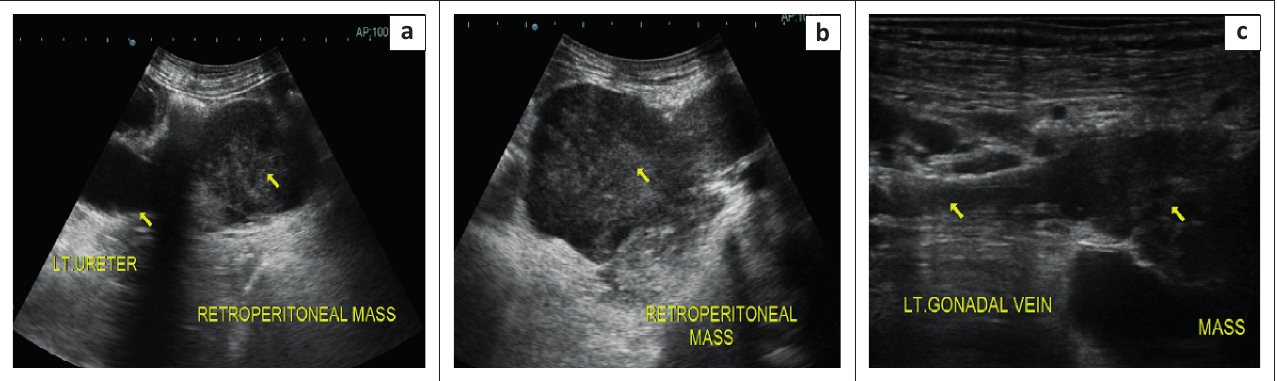
FIGURE 1: (a–c) Ultrasound abdomen showing retroperitoneal mass of heterogeneous echotexture along the course of the left gonadal vein involving adjoining left ureter with proximal hydroureter.